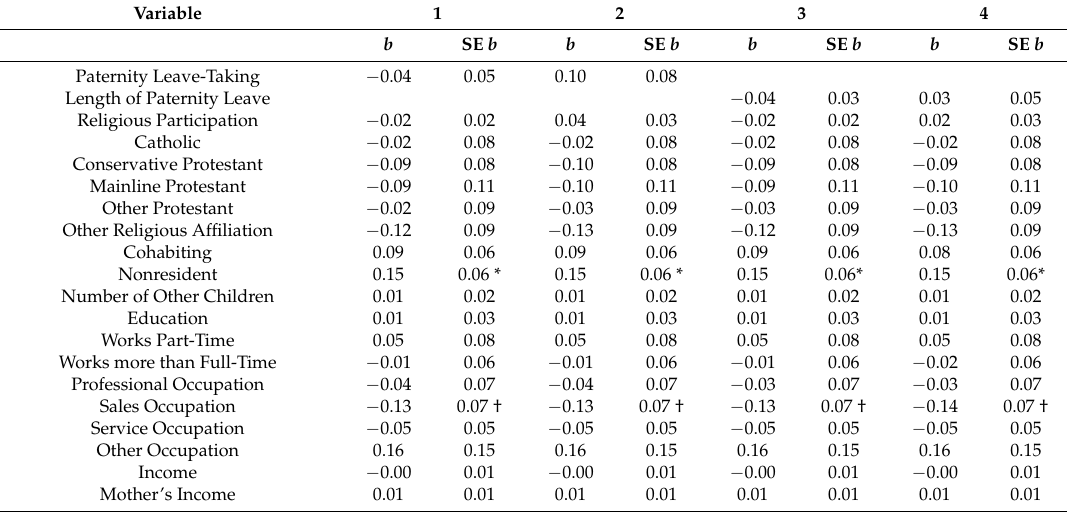
Table 3. Results from OLS regression models predicting relationship conflict.